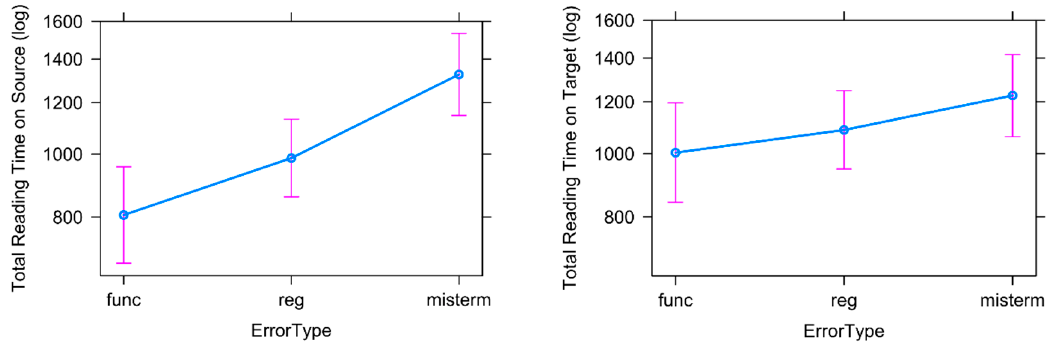
Figure 8. E ff ect of Error Type on total reading times in ST ( left ) and TT ( right ). Figure 8. Effect of Error Type on total reading times in ST ( left ) and TT ( right ).